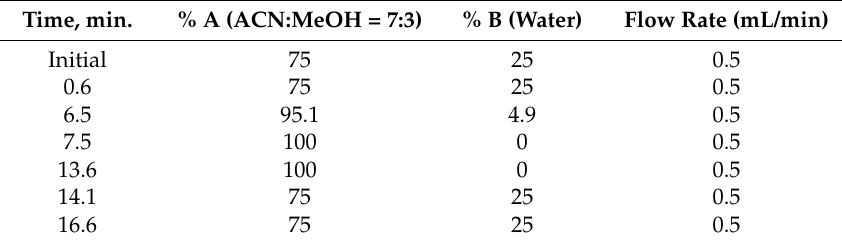
Table 1. UPLC gradient